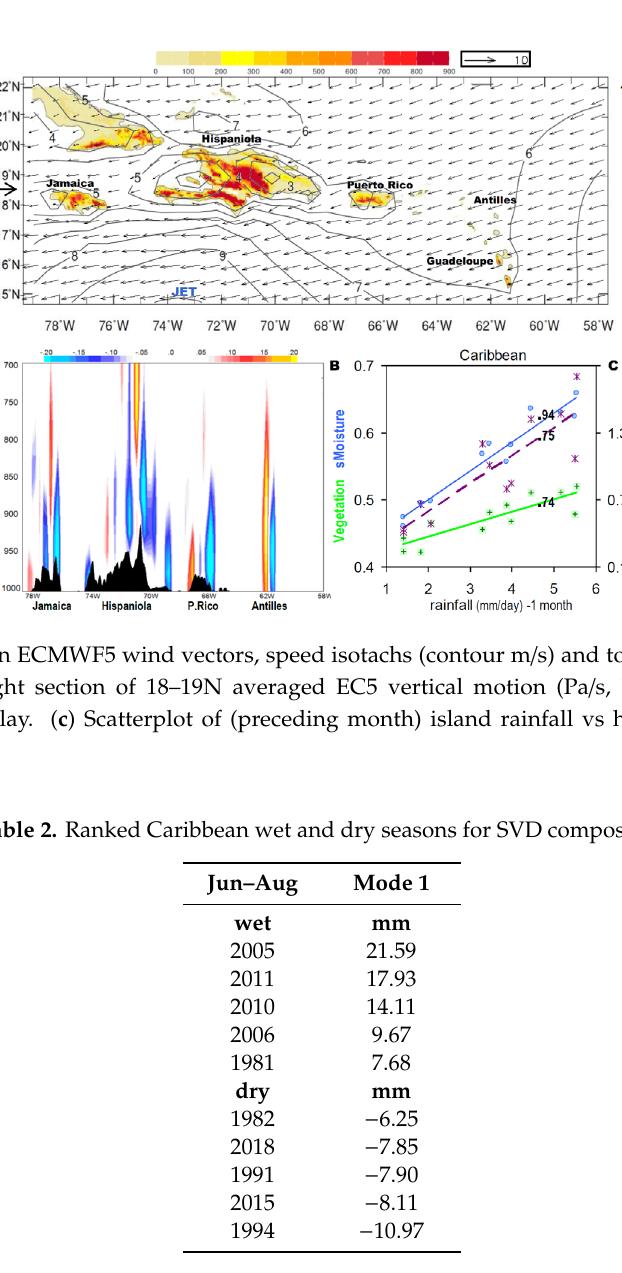
Table 3. Day-0 of Caribbean easterly waves in the composite analysis. Year